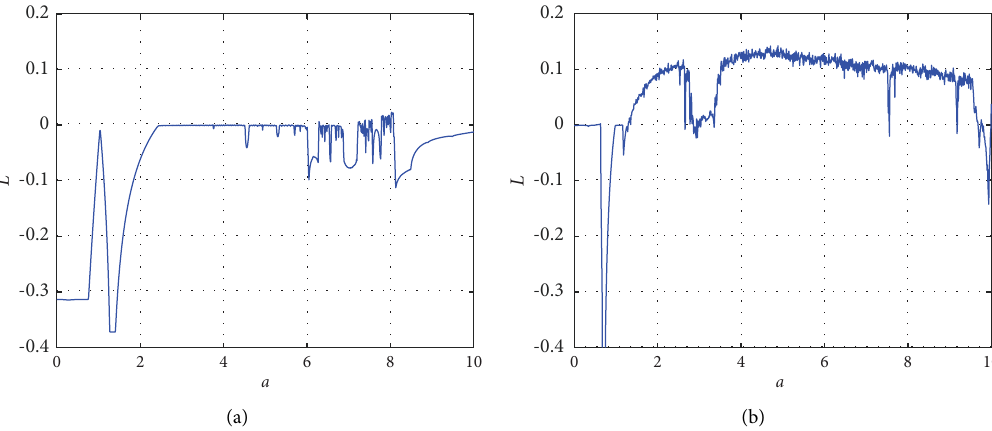
Figure 9: Jury criteria J the left of a C represent the Jury criteria, and we fnd from the pure prey map (27)).